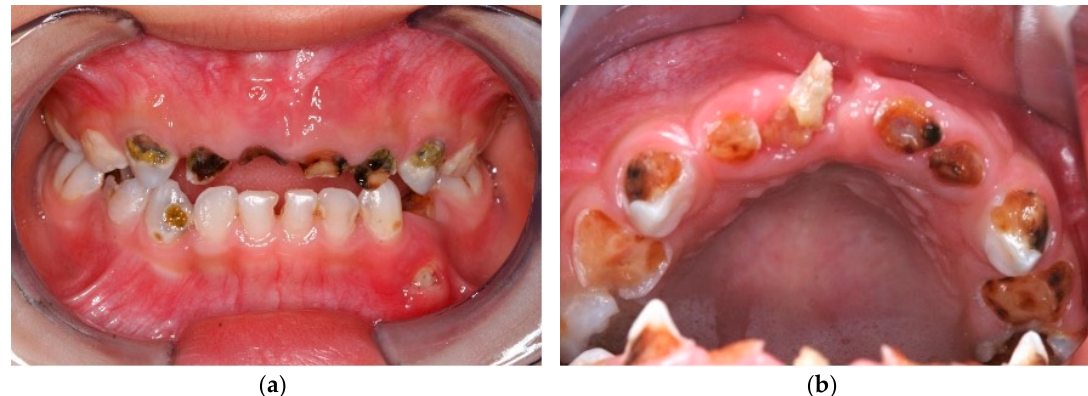
Figure 1. Early childhood caries (ECC) of a 4-year-old Hong Kong child. ( a ) ECC causes pain and infection; ( b ) severe ECC affected this child’s nutrition, growth, physical and psychological development and general health.